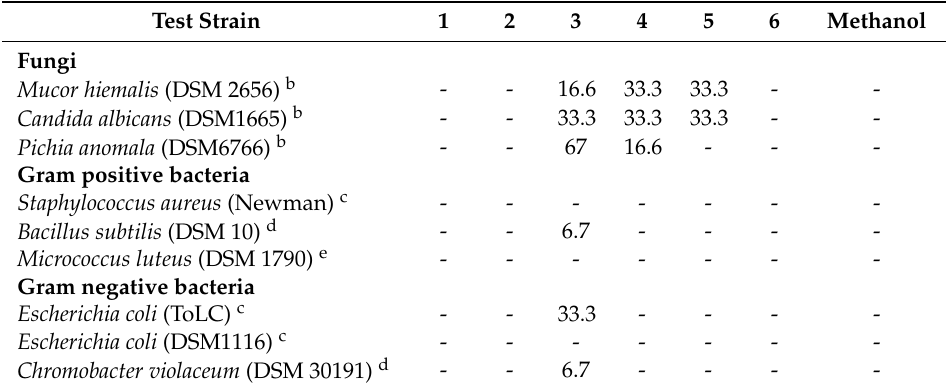
Table 3. Antimicrobial activity ( µ g/mL) of compounds 1 – 6. Methanol was used as a negative control. Test